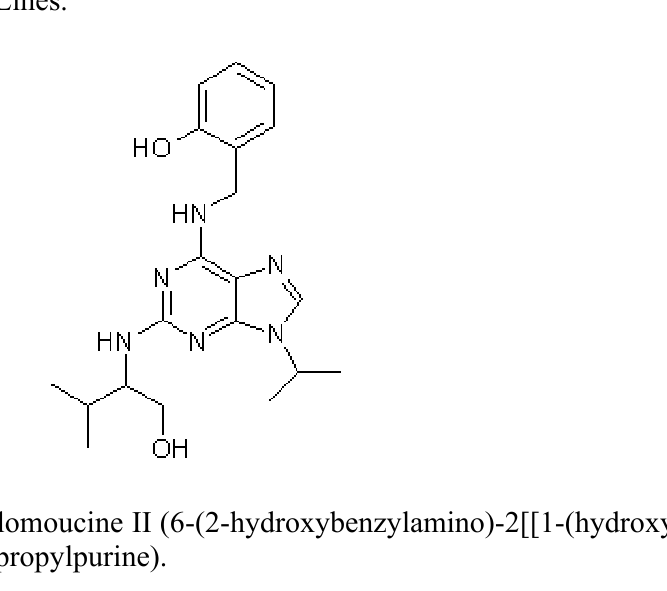
and GI Values for Various Purine Derivatives Tested on cdk1, 50 50